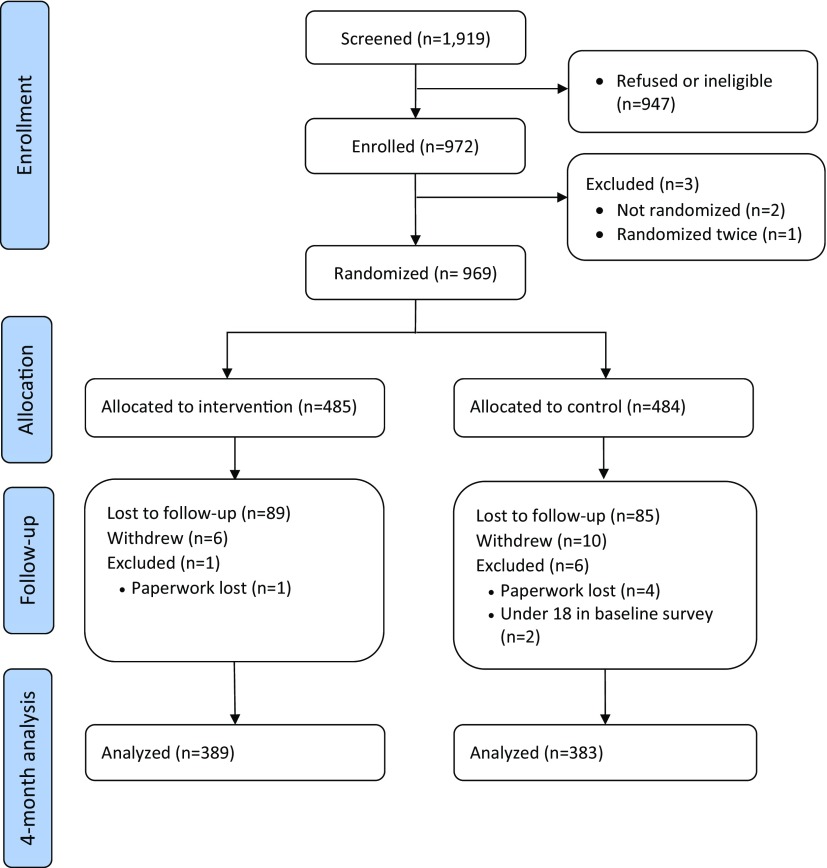
Flowchart of Participants in a Randomized Controlled Trial of a Mobile Phone Intervention Designed to Support Post–Menstrual Regulation Contraceptive Use in Bangladesh (2015–2016)